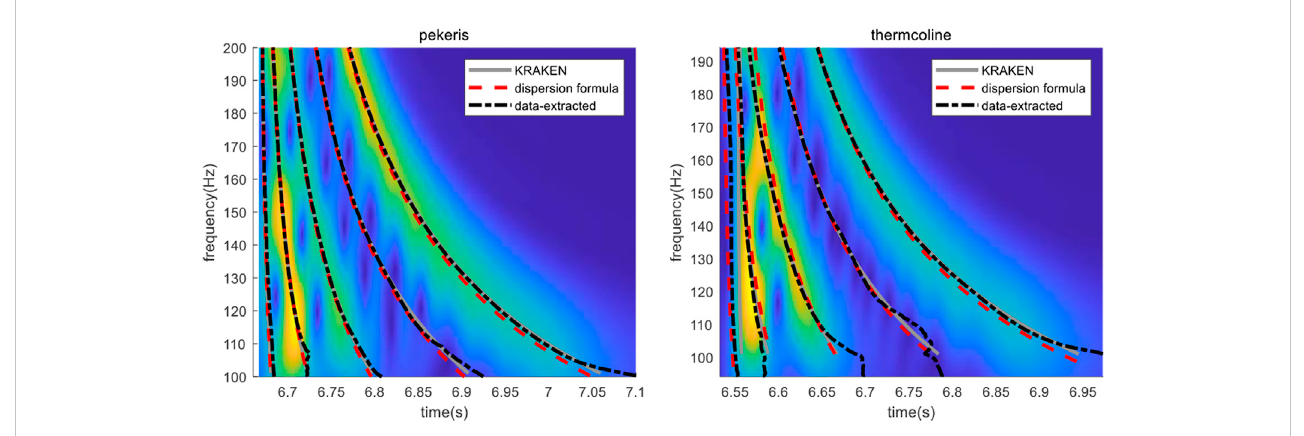
FIGURE 5 Dispersion curves calculated with different methods (A) in the Pekeris waveguide and (B) a thermocline